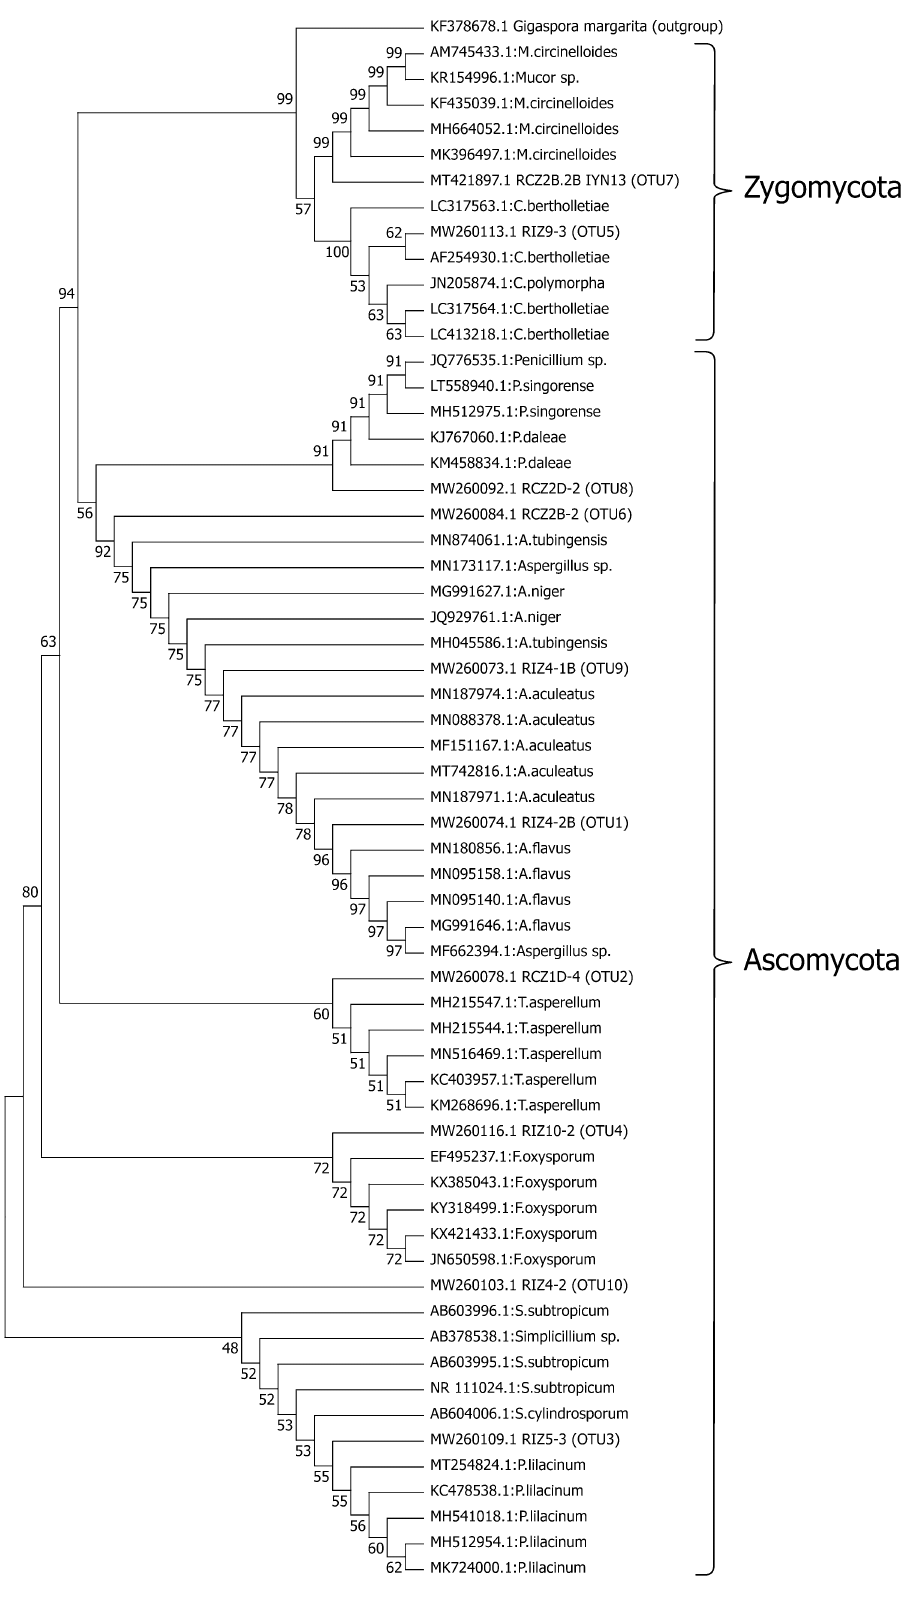
Fig. 5 Neighbor-joining phylo- genetic tree of ten representa- tive OTUs of the isolates with coal activity and their relatives. Branches corresponding to partitions reproduced in less than 50% bootstrap replicates are collapsed. The percent- age of replicate trees in which the associated taxa clustered together in the bootstrap test (1000 replicates) is shown next to the branches. The evolutionary distances were computed using the maximum composite likelihood method and are in the units of the number of base substitutions per site. This analysis involved 61 nucleotide sequences. Codon positions included were 1st + 2nd + 3rd + Noncoding. All ambiguous positions were removed for each sequence pair (pairwise deletion option). There was a total of 154 positions in the final dataset. Evolutionary analyses were conducted in MEGA